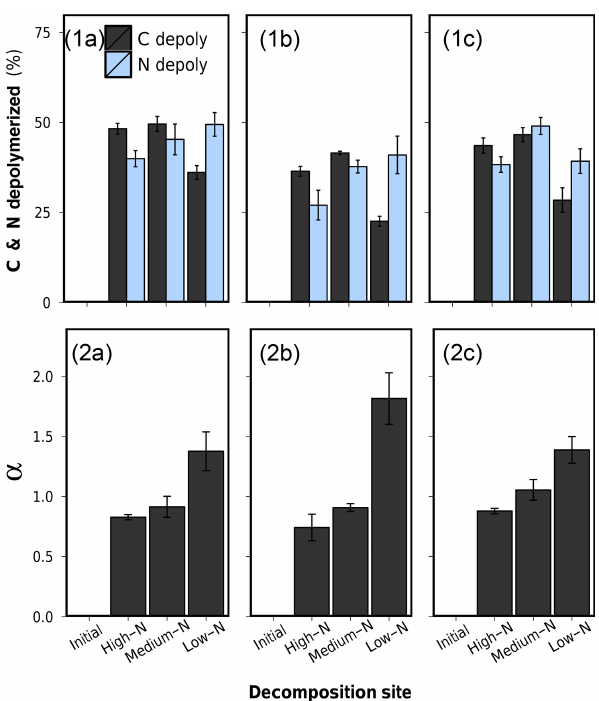
Figure 7. (1) Depolymerized plant C and depolymerized plant N after 75d of anaerobic litter decomposition, and (2) the coefficient of preferential protein depolymerization α ( = N depoly / C depoly ). (a) Low-N leaf litter, (b) medium-N leaf litter, and (c) high-N leaf litter. Error bars represent standard deviations of three replicate lit-